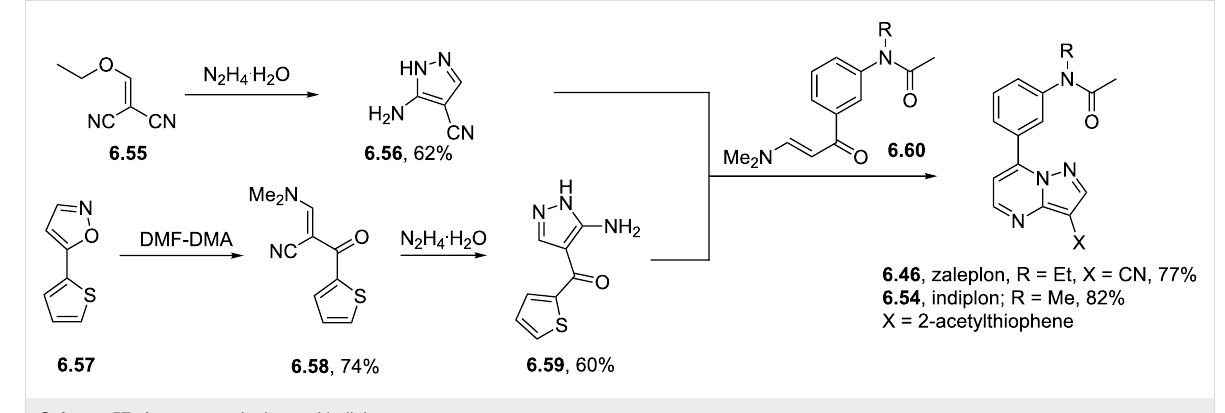
Scheme 57: Access to zaleplon and